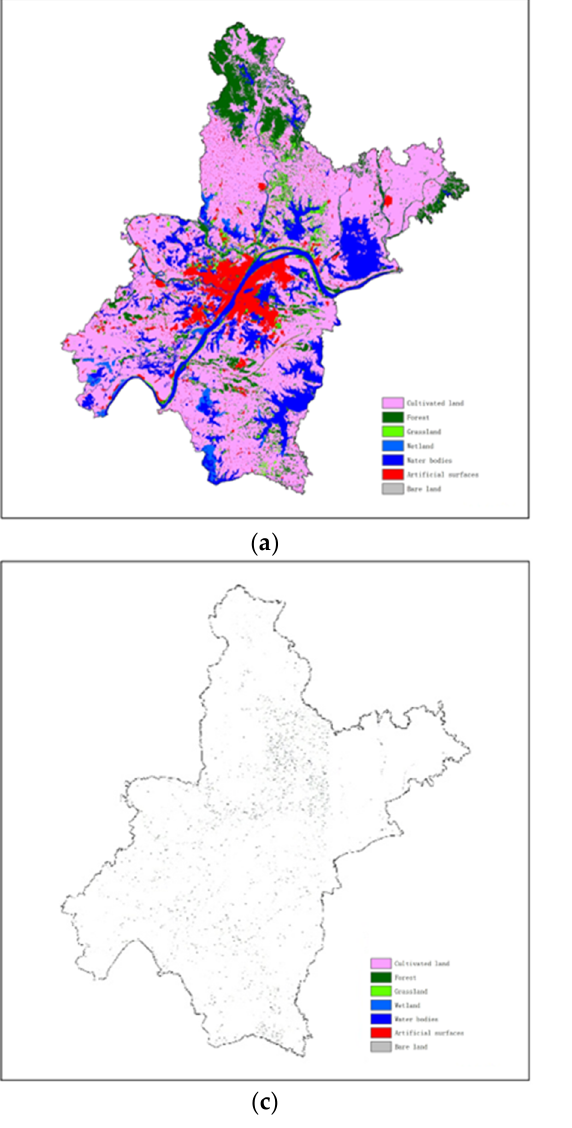
Figure 5. Land cover representations augmented with: ( a ) the primary classes, ( b ) the alternate classes for mixed pixels, and ( c ) the third most probable classes for highly mixed pixels.